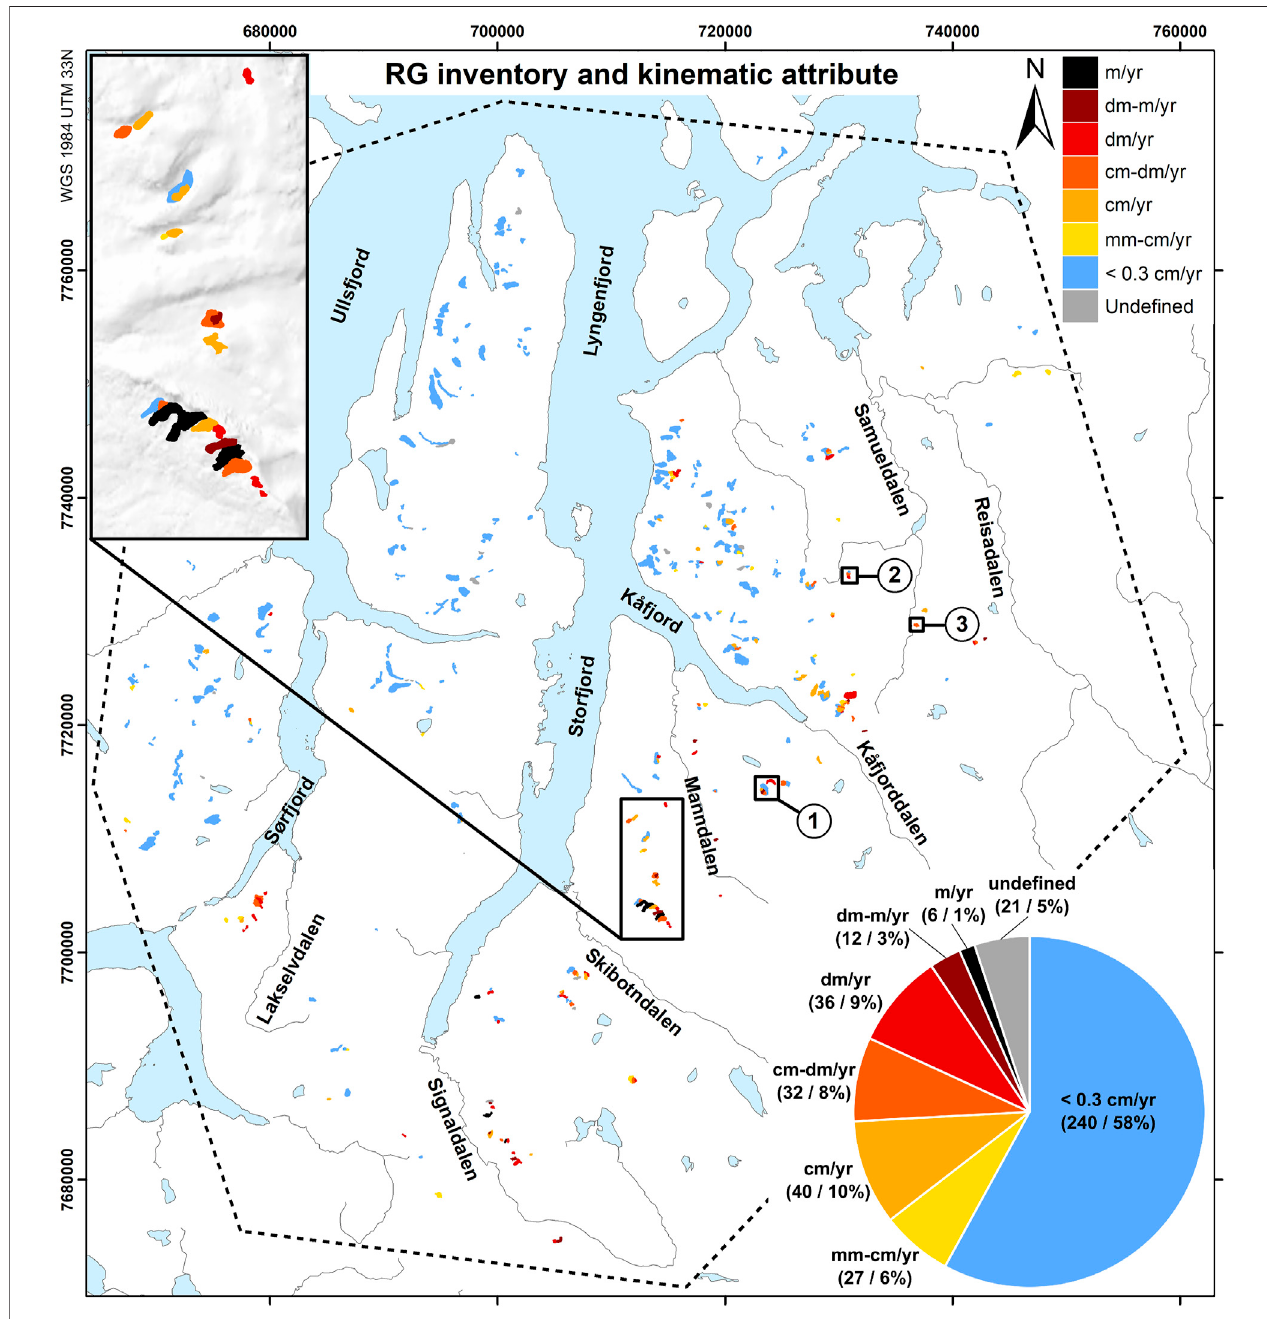
FIGURE9| Updatedrockglacier(RG)inventoryconsistingof414unitsin340systemsandvariabilityofthekinematicattributeinthestudyarea.Insetmap (upper- left corner) : detailed view over an area including several landforms with variable kinematic attributes. Pie chart (lower-right corner) : kinematic attributes for all inventoried RG units. Numbers 1 – 3 are the locations of examples shown in Figure 8 . Sea, lakes, rivers and reference names from NMA (2020a).